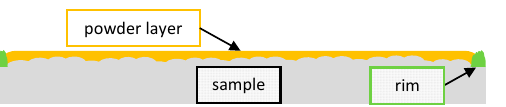
Figure 4. Illustration of the additively manufactured sample with the rim (green) to enable manual coating with reproducible height of the powder layers (orange).